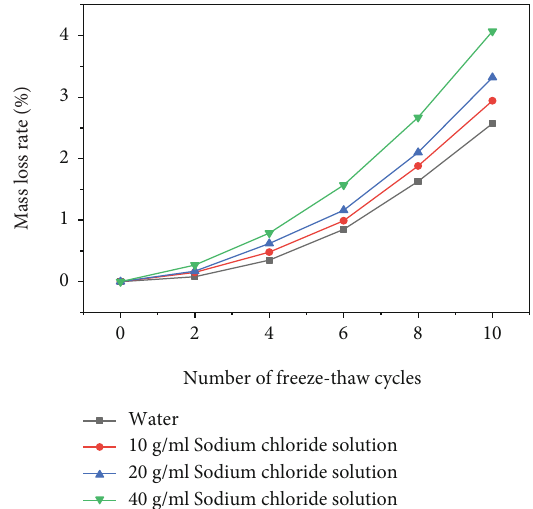
Figure 5: Variation of sample mass with the number of cycles. Figure